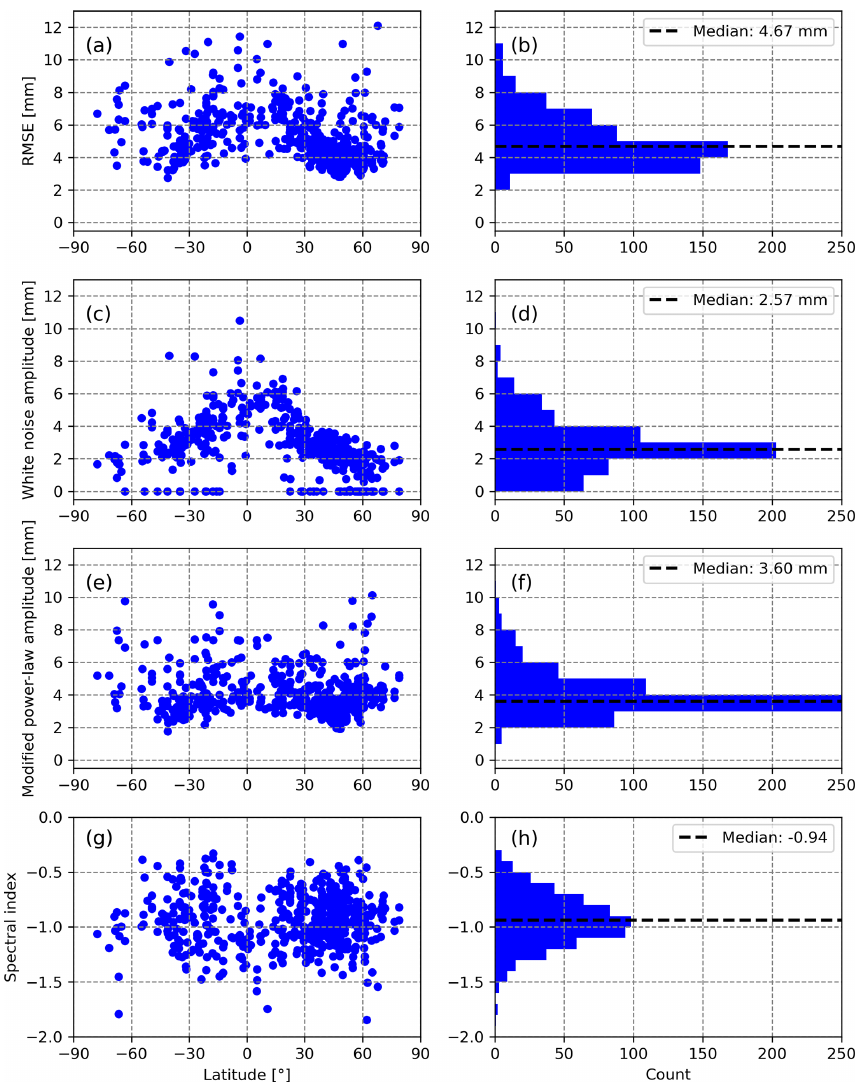
Figure 6. Vertical position time series of (a, b) RMSE values, (c, d) white noise amplitudes, (e, f) modified power-law amplitudes, and (g, h) spectral indices. See the text for